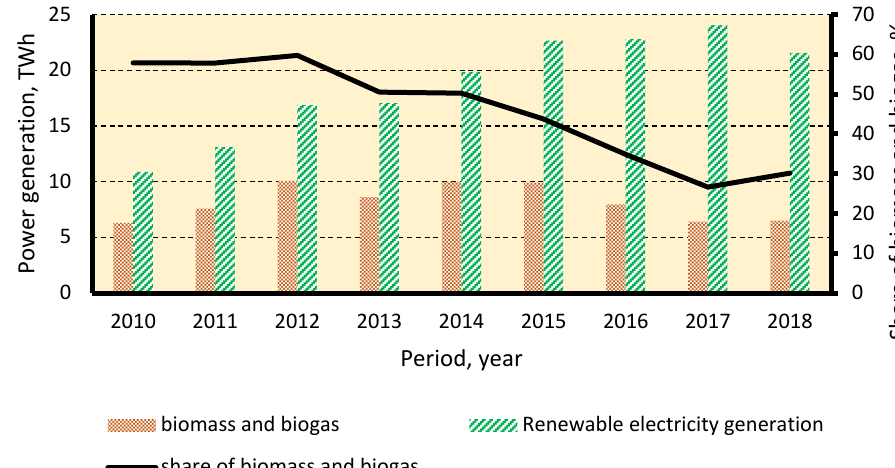
Figure 1. Renewable electricity generation.